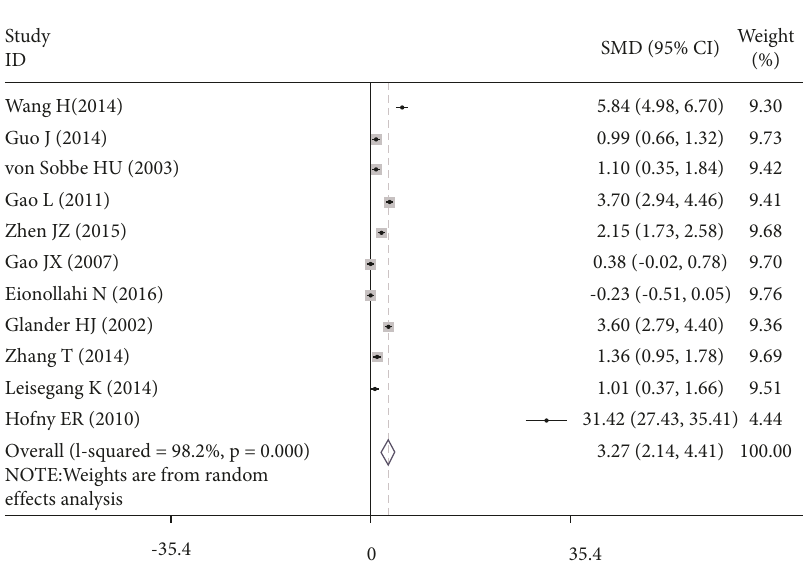
Figure 3: The SMD of leptin concentration in seminal and male infertility risk. SMD: standardized mean difference. Note: weights are from the random-effects